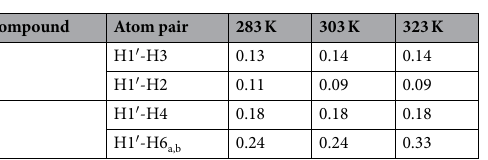
Table 4. NOE values (relative to H1 ′ -H2 ′ NOE value) at different temperatures for compounds 1 and 2